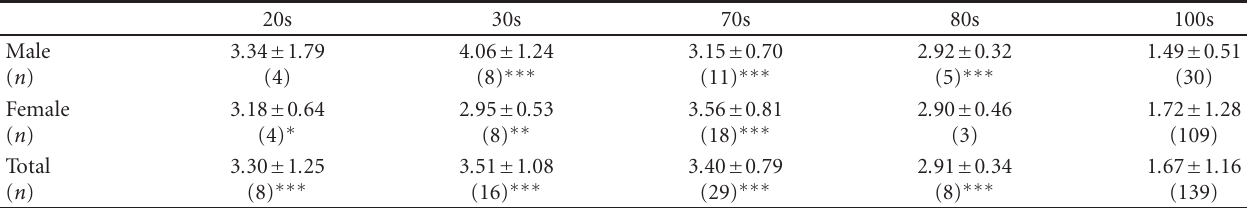
Table 1: Plasma lipid peroxide in young, middle-aged, and older age groups (mean and SD), nmol/ml. LPO levels were measured using the TBA method [21, 22].